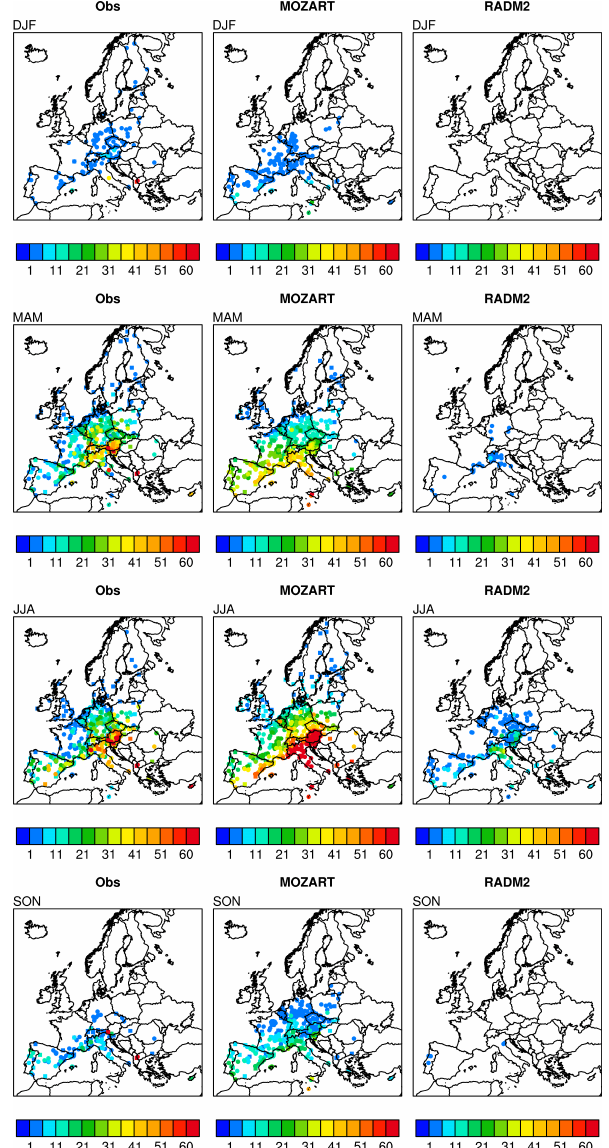
Figure 7. Number of days of exceedances of the EU long-term objective value for MDA8 (120µgm − 3 ) at AirBase (circles) and EMEP (squares) station locations. Shown are totals by season for observations and the MOZART and RADM2 simulations. For sim- plicity of viewing the data, stations with no exceedances are not